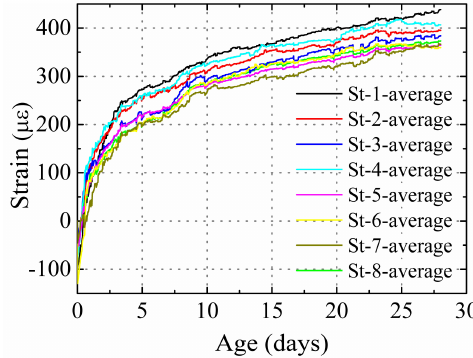
Figure 12. Average shrinkage of the specimens.